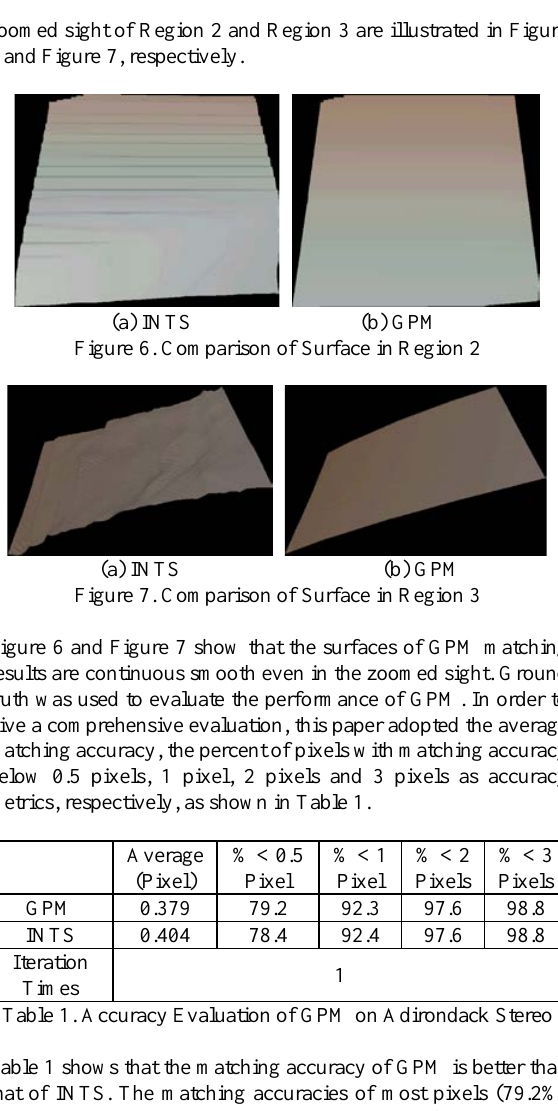
Figure 5. Matching Results on Adirondack